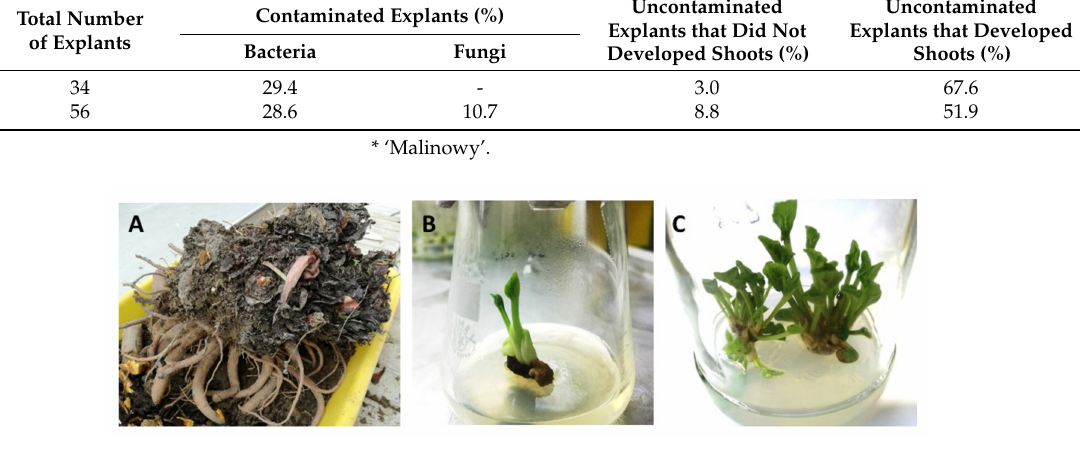
Figure 1. Initiation and stabilization stage of culinary rhubarb ‘Malinowy’ micropropagation: ( A ) 8-year-old mother plant collected from the plantation at the beginning of November; ( B ) initial shoot developed from axillary bud after 3 weeks of culturing in initiation medium; ( C ) the multiplied shoots at the stabilization stage. Table 2. Influence of nitrogen salts (75% and 100% MS medium) and growth regulators on the survival rate and initial shoot formation of rhubarb ‘Malinowy’ after 3 subcultures in the same fresh